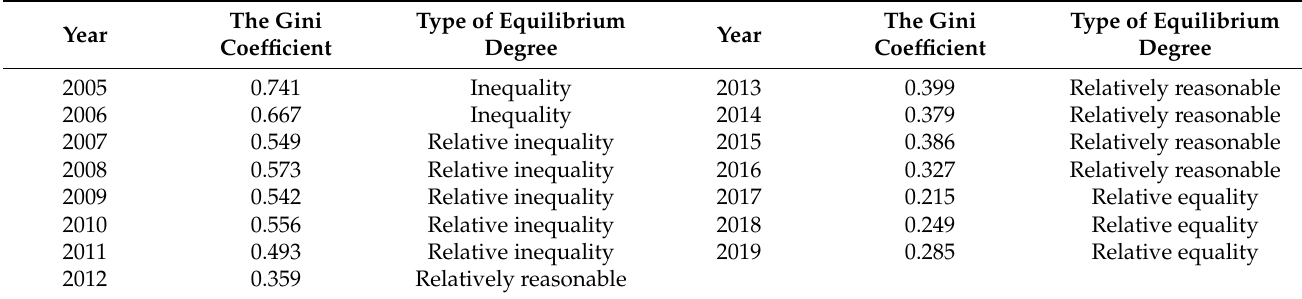
Table 2. Gini coefficient calculation results of A-level scenic spots in